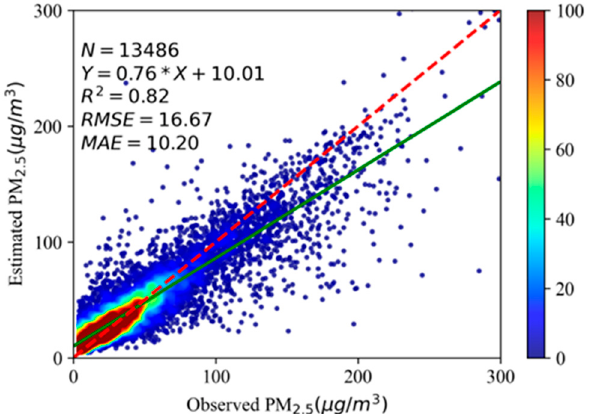
Figure 5. A 10-fold, cross-validation scatter plot of the NightPMES model in the BTH region. Green solid line: fitting line, and the red dotted line : 1:1 line.